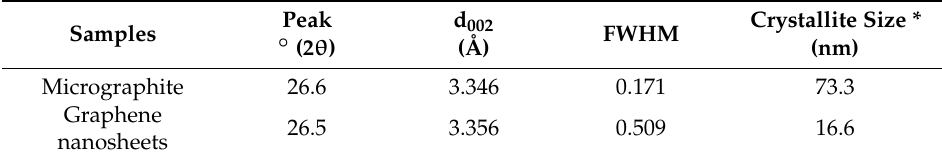
Figure 1. XRD patterns of micrographite (MG), graphene nanosheets (GNS) and LaB6 samples. Inset: XRD patterns of MG and GNS recorded from 5° to 40° (2 θ ). Table 2. Structural parameters of the studied materials derived from their XRD patterns.